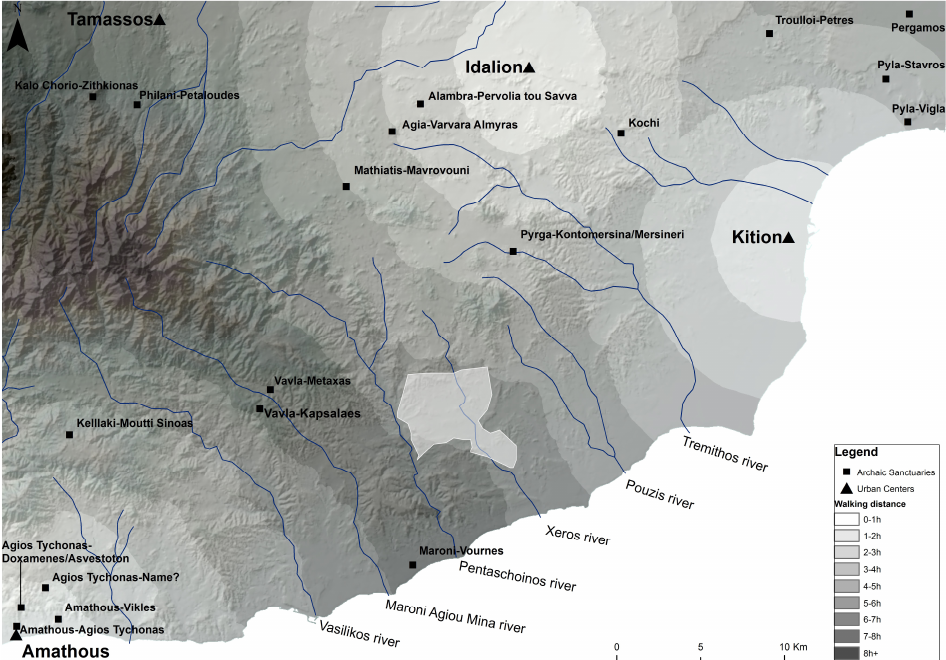
Figure 12. In the Cypro-Archaic period, the Xeros River valley became a flourishing territory at the intersection of various Iron Age polities. Digital data courtesy of the Geological Survey Department, Republic of Cyprus (Map by Niki Kyriakou).